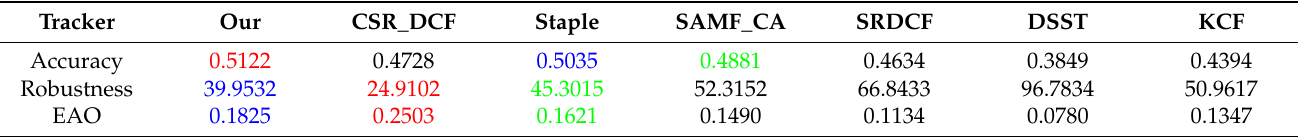
Table 3. A comparison with the state-of-the-art trackers on VOT-2018 dataset. The best method is shown in red, and the second and third are shown in blue and green,